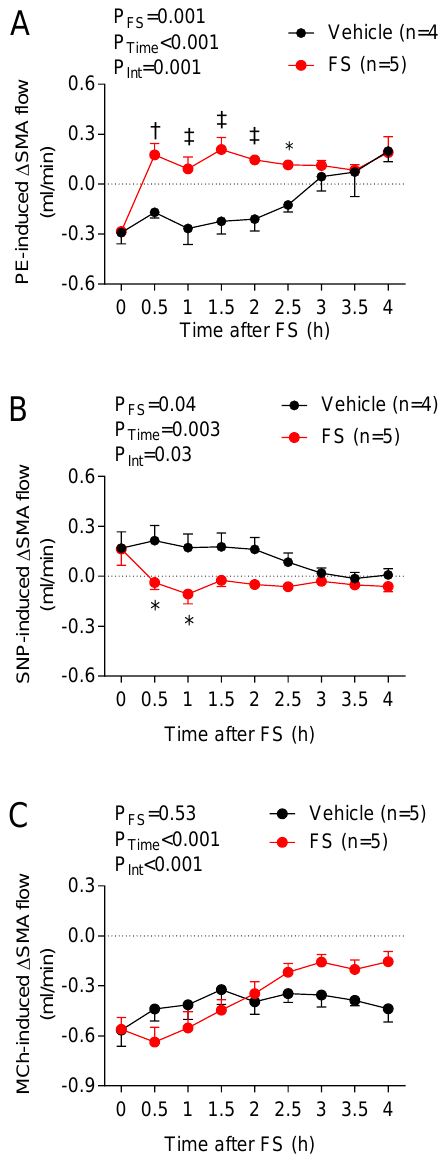
Figure 5. Fecal slurry (FS)-induced peritonitis caused progressive changes in superior mesenteric artery (SMA) blood flow responses to bolus doses of ( A ) phenylephrine (PE), ( B ) sodium nitroprusside (SNP), and ( C ) methylcholine (MCh) over time in mice. Data were analyzed by two-way ANOVA for the effects of FS and time, followed by the Holm–Sidak post hoc test for multiple comparisons. * p < 0.05, † p < 0.01, and ‡ p < 0.001 compared with the vehicle at the same time.